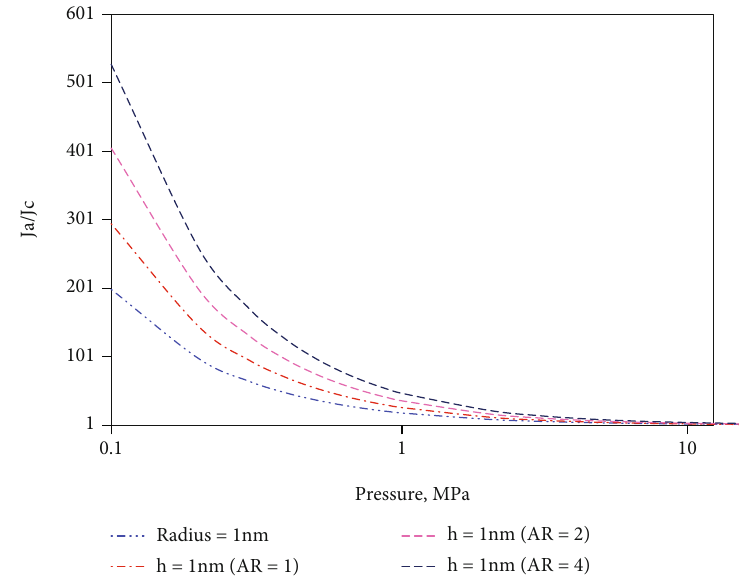
Figure 5: Gas transport capacity versus pressure with di ff erent cross-section shapes.